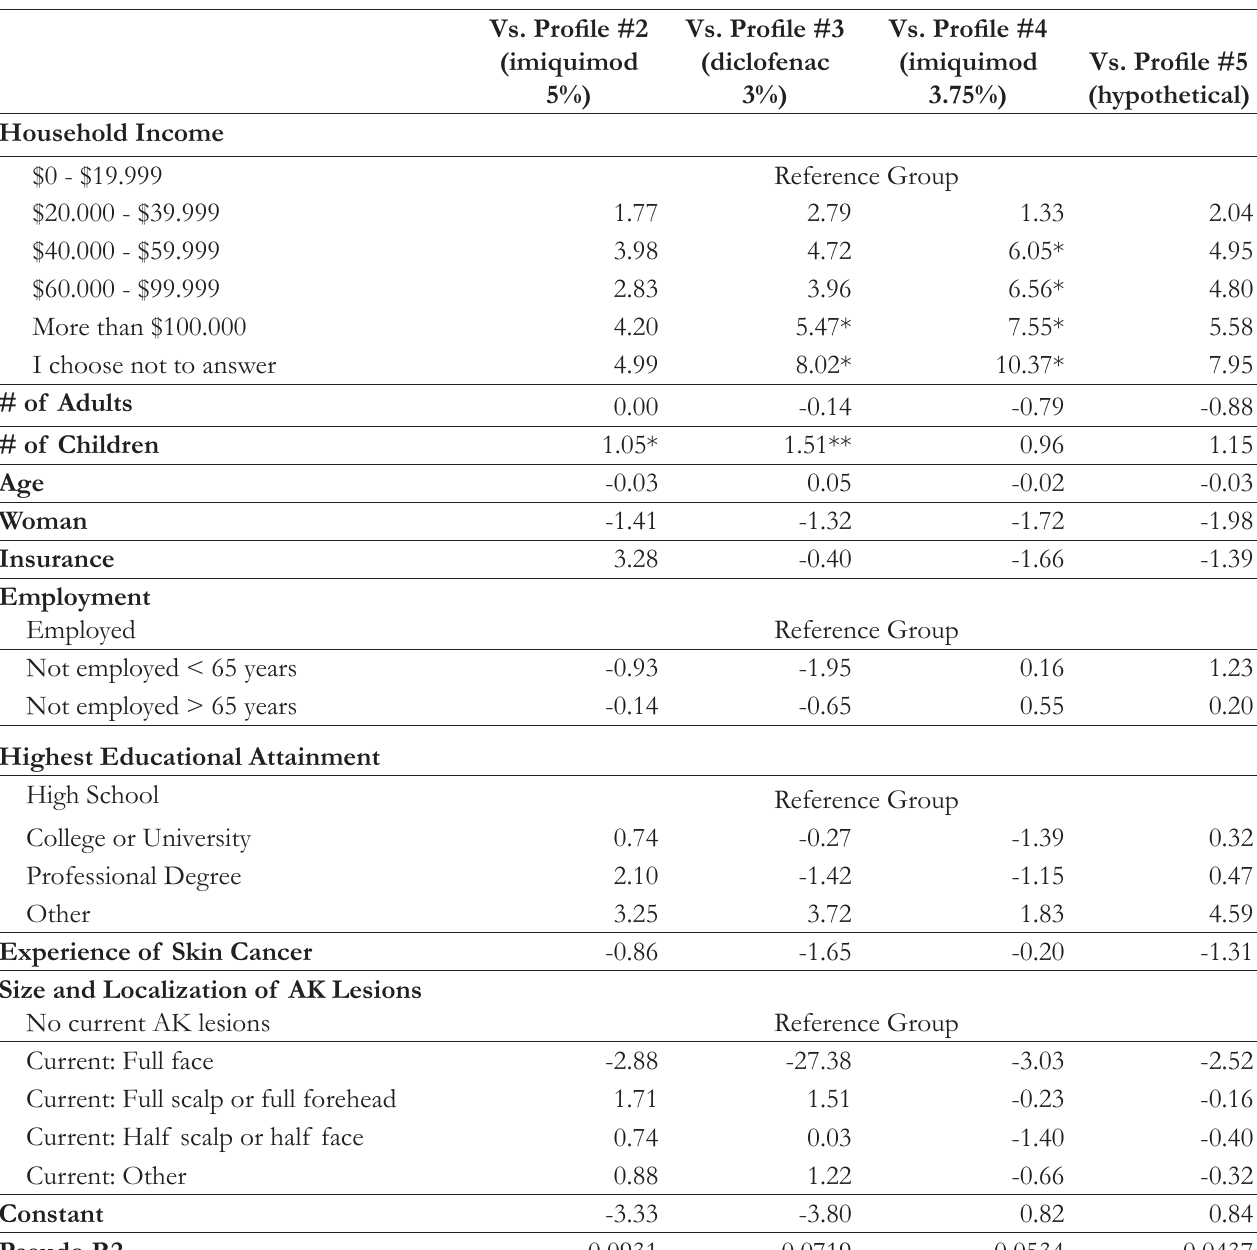
Table 5. Multivariate Tobit Regression of the Determinants of Incremental WTP for Ingenol Mebutate Gel vs. Four Treatment Profiles – Logarithmally Transformed